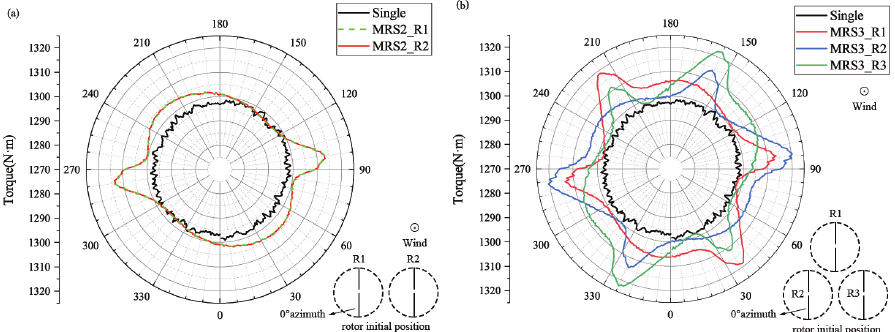
Figure 7. Torque–Azimuth angle: ( a ) Twin-rotor; and ( b ) tri-rotor wind turbine.